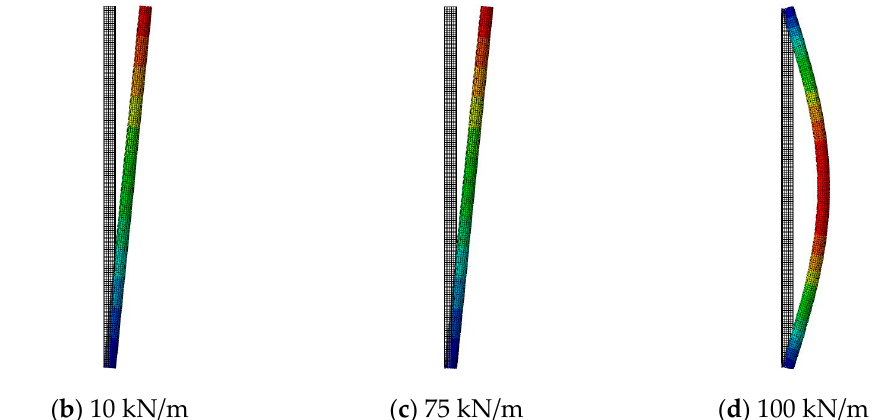
Figure 10. Buckling shapes according to the stiffness of one end of the vertical member in the translational direction.